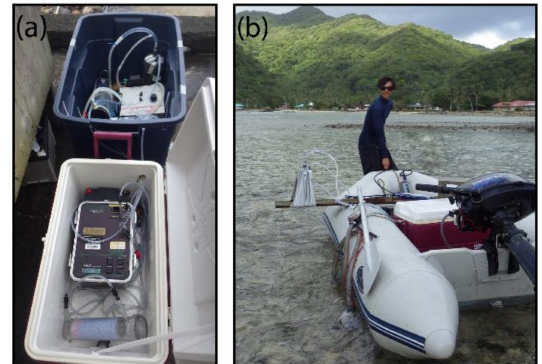
Figure 3. ( a ) Instrument package used for measuring dissolved 222 Rn and water quality parameters for time-series measurements. ( b ) The same instrument package transferred and mounted to an inflatable boat for 222 Rn survey